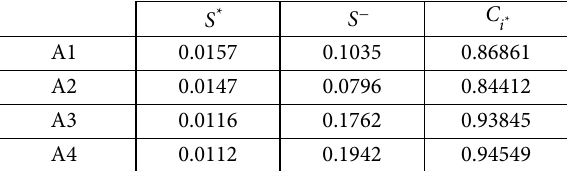
Table 5. Final scores for candidate locations